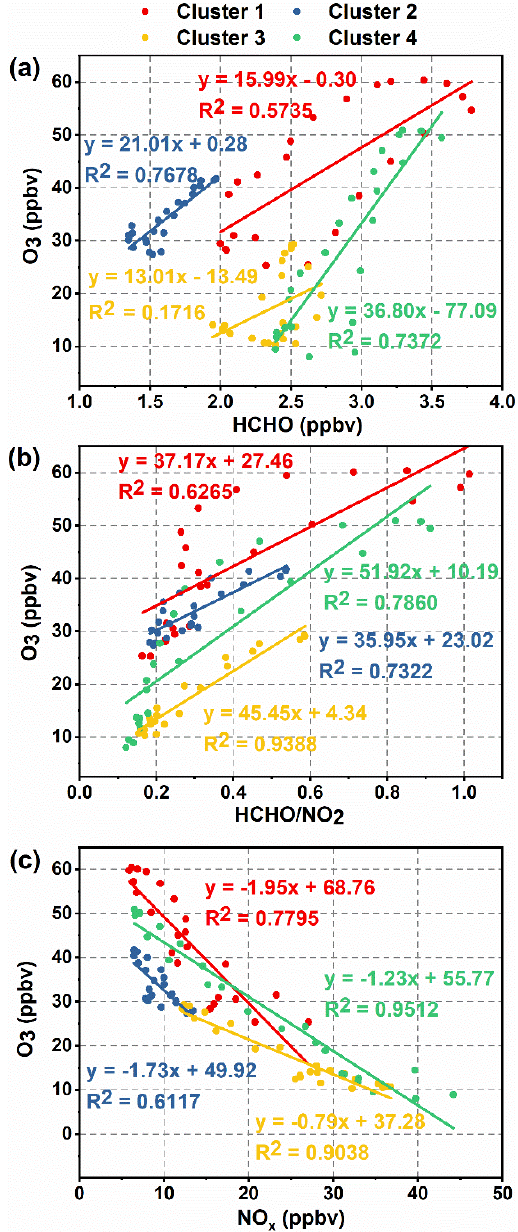
Figure 7. The O 3 concentrations and corresponding HCHO concentrations ( a ), HCHO/NO 2 ratios ( b ), and NO x concentrations ( c ) for the four clusters. Colored lines represent the linear fit for each cluster.